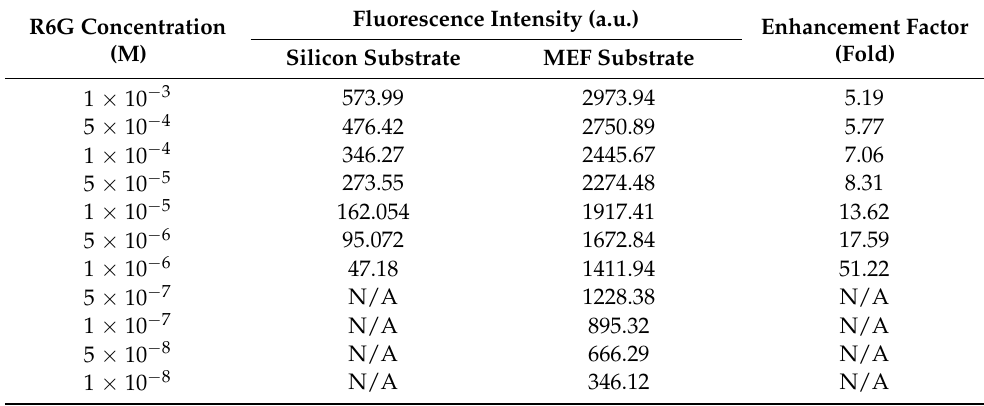
Table 1. Fluorescence intensity of R6G measured on silicon substrate and MEF substrate. R6G Concentration Fluorescence Intensity (a.u.) (Fold)Silicon